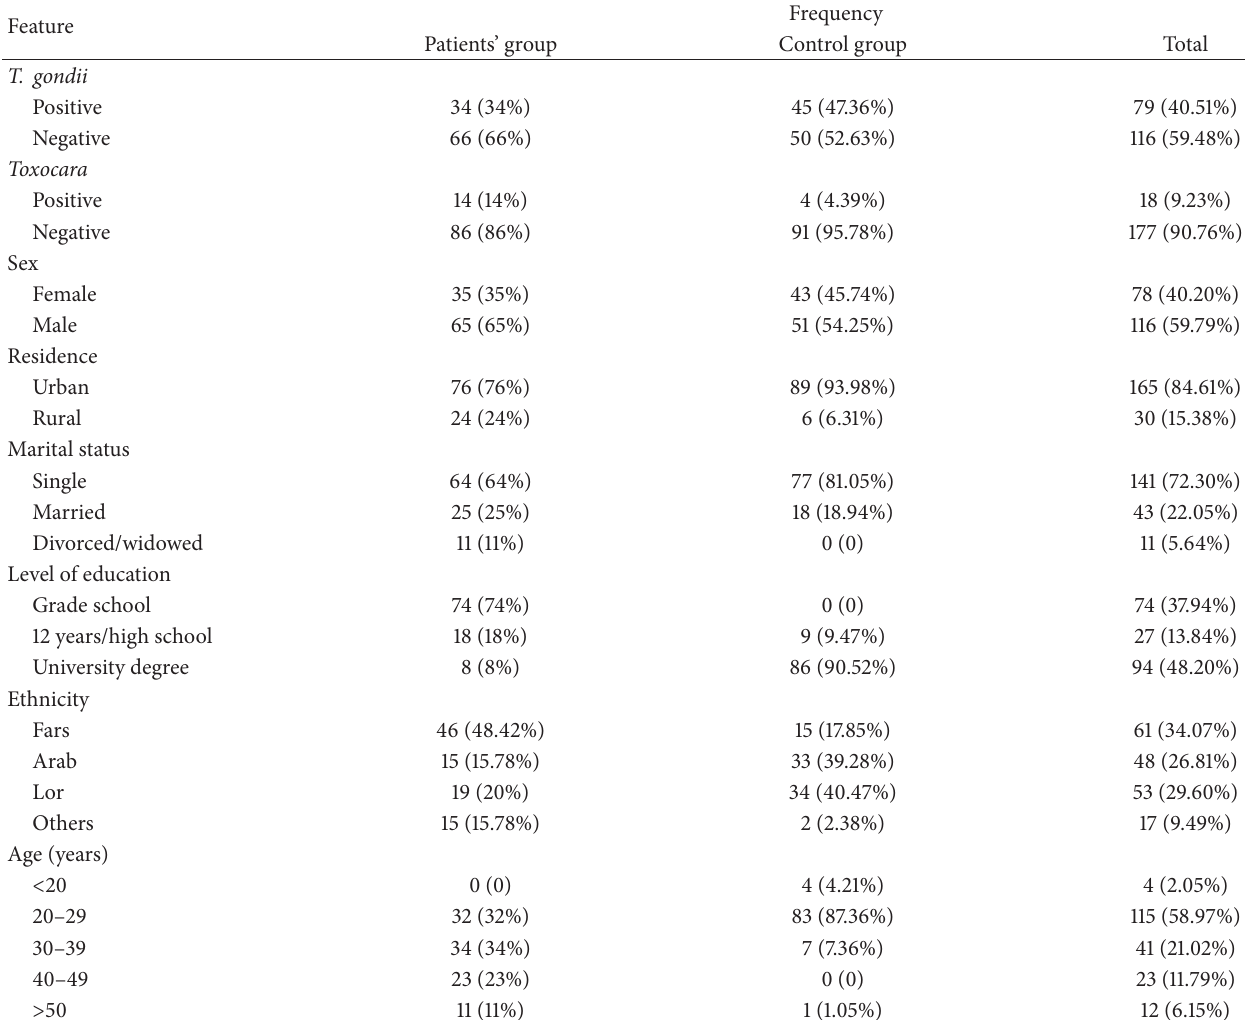
Table 1: Demographic characteristics of the patient and control groups.